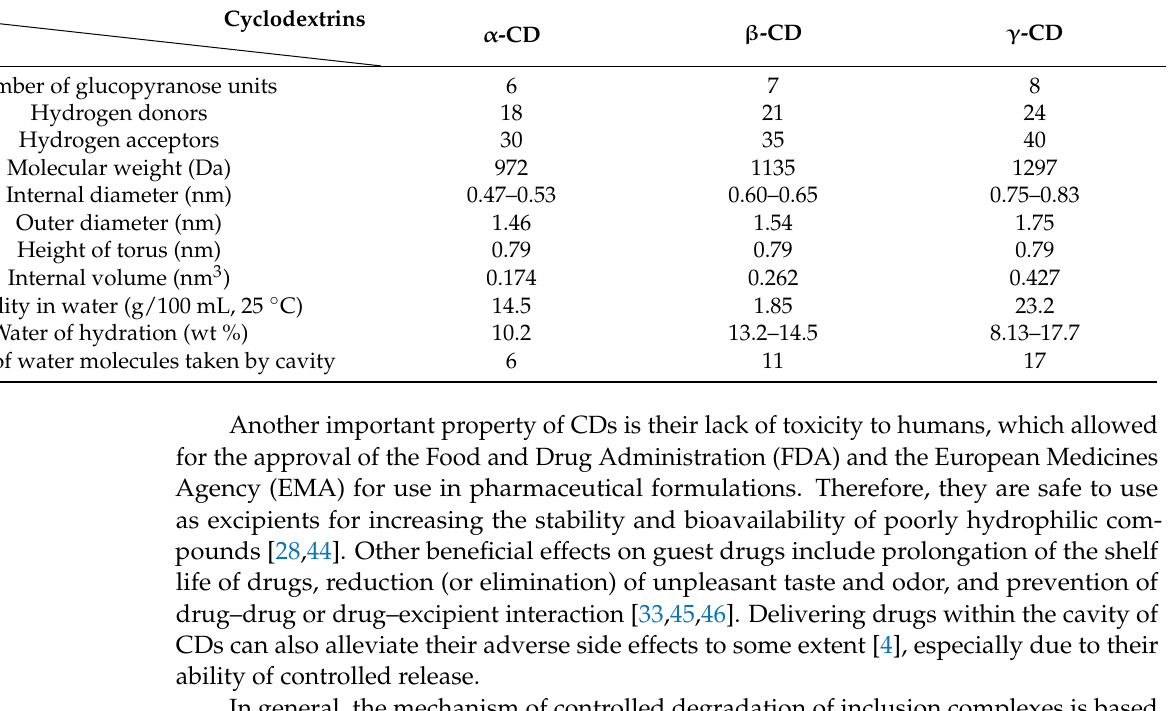
Table 1. Main properties of native cyclodextrins (CDs). Created based on information from